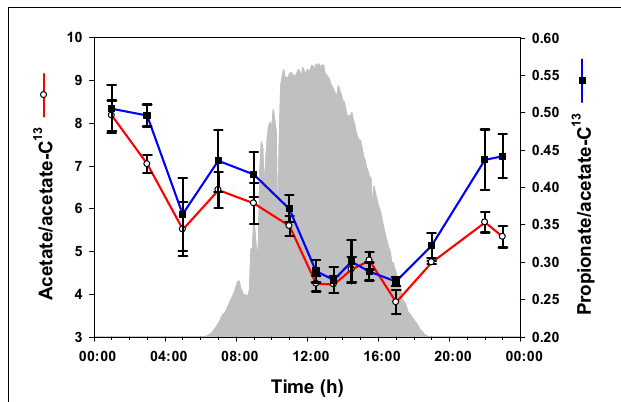
FIGURE 3 | Volatile metabolites over the diel cycle. Solar irradiance (solid gray) and acetate and propionate concentrations in unrinsed mat samples are shown. Metabolite values plotted are mean ± standard error ( n = 3 ).